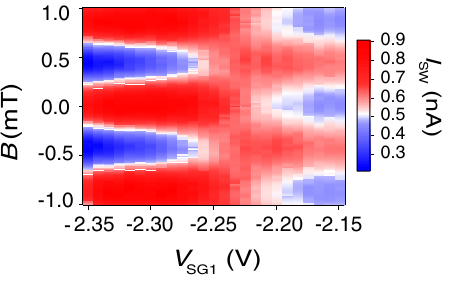
FIG. 11. Complete modulation of the switching current by the applied magnetic field around the 0 - (cid:1) transition. I SW vs mag- netic field and sidegate voltage V SG1 around the 0 - (cid:1) transition in JJ1, corresponding to the trace in Figs. 4(d)–4(f). The 0 state is stabilized for V SG1 < (cid:1) 2 : 25 V , while the (cid:1) state occurs for > (cid:1) 2 : 20 V . Nonharmonic behavior of I V SG1 of magnetic flux is clearly observed in the intermediate transition range.